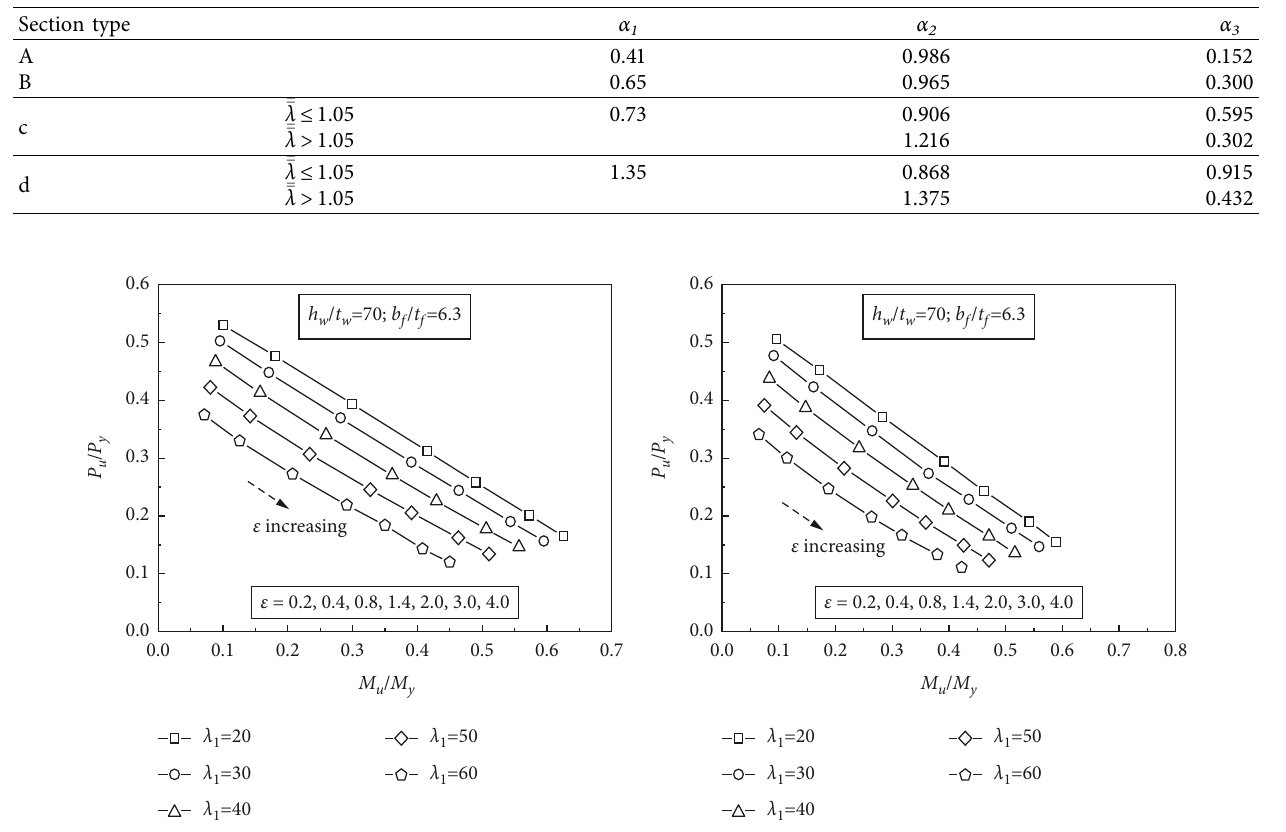
Table 4: α 1 , α 2 , α 3 for overall buckling factor in